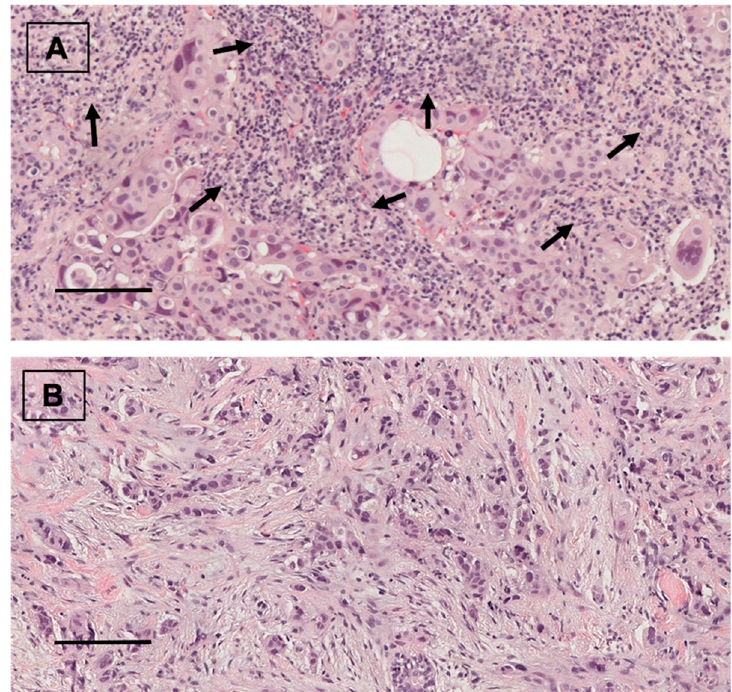
Figure 3. ( A ) TIL infiltration in breast carcinoma (arrows). Hematoxylin and eosin staining. ×20. scale bar = 100 µm. ( B ) Breast carcinoma without TIL infiltration. Hematoxylin and eosin staining. ×20, scale bar = 100 µm .